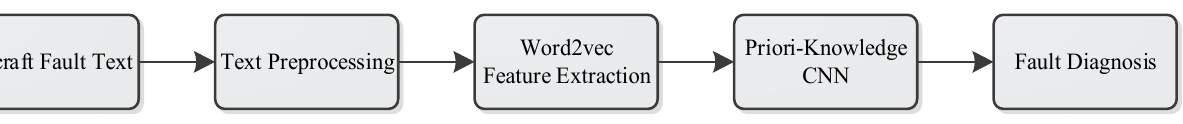
Figure 1. The Proposed Aircraft Fault Diagnosis Model Structure .